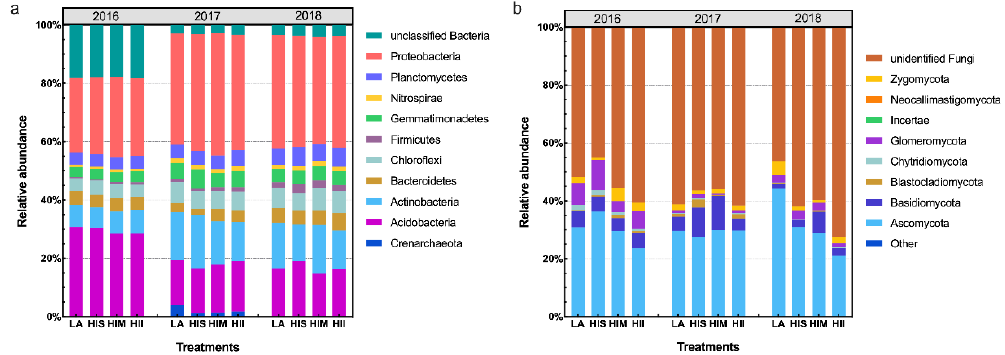
Figure 3. Bacterial community composition at the phylum level ( a ), and fungal community composition at the phylum level ( b ).